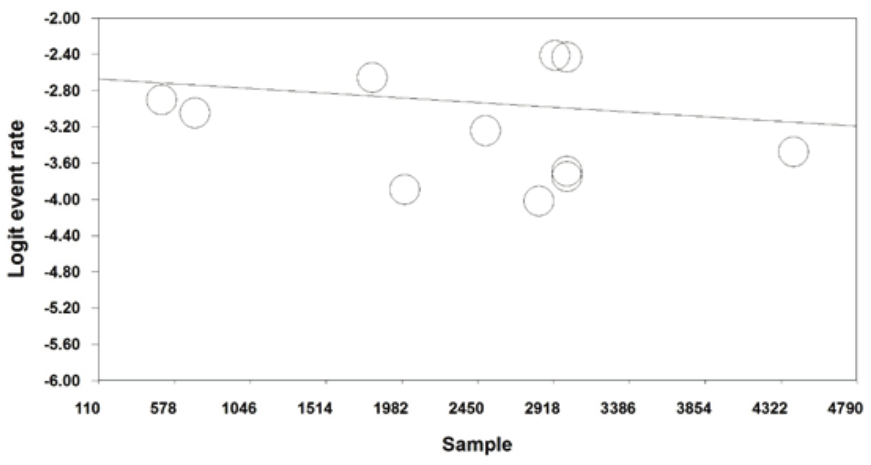
Figure 8. Heterogeneity check diagram of the color blindness by sample